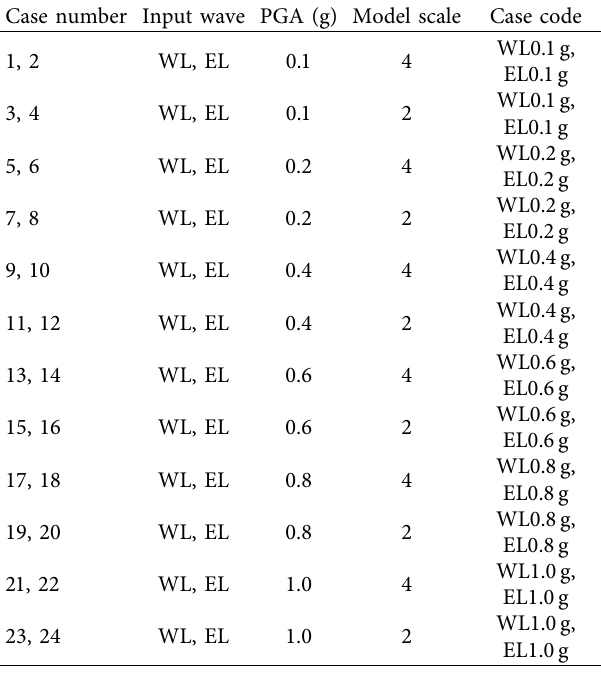
Table 3: Loading cases. Case number Input wave PGA (g) Model scale